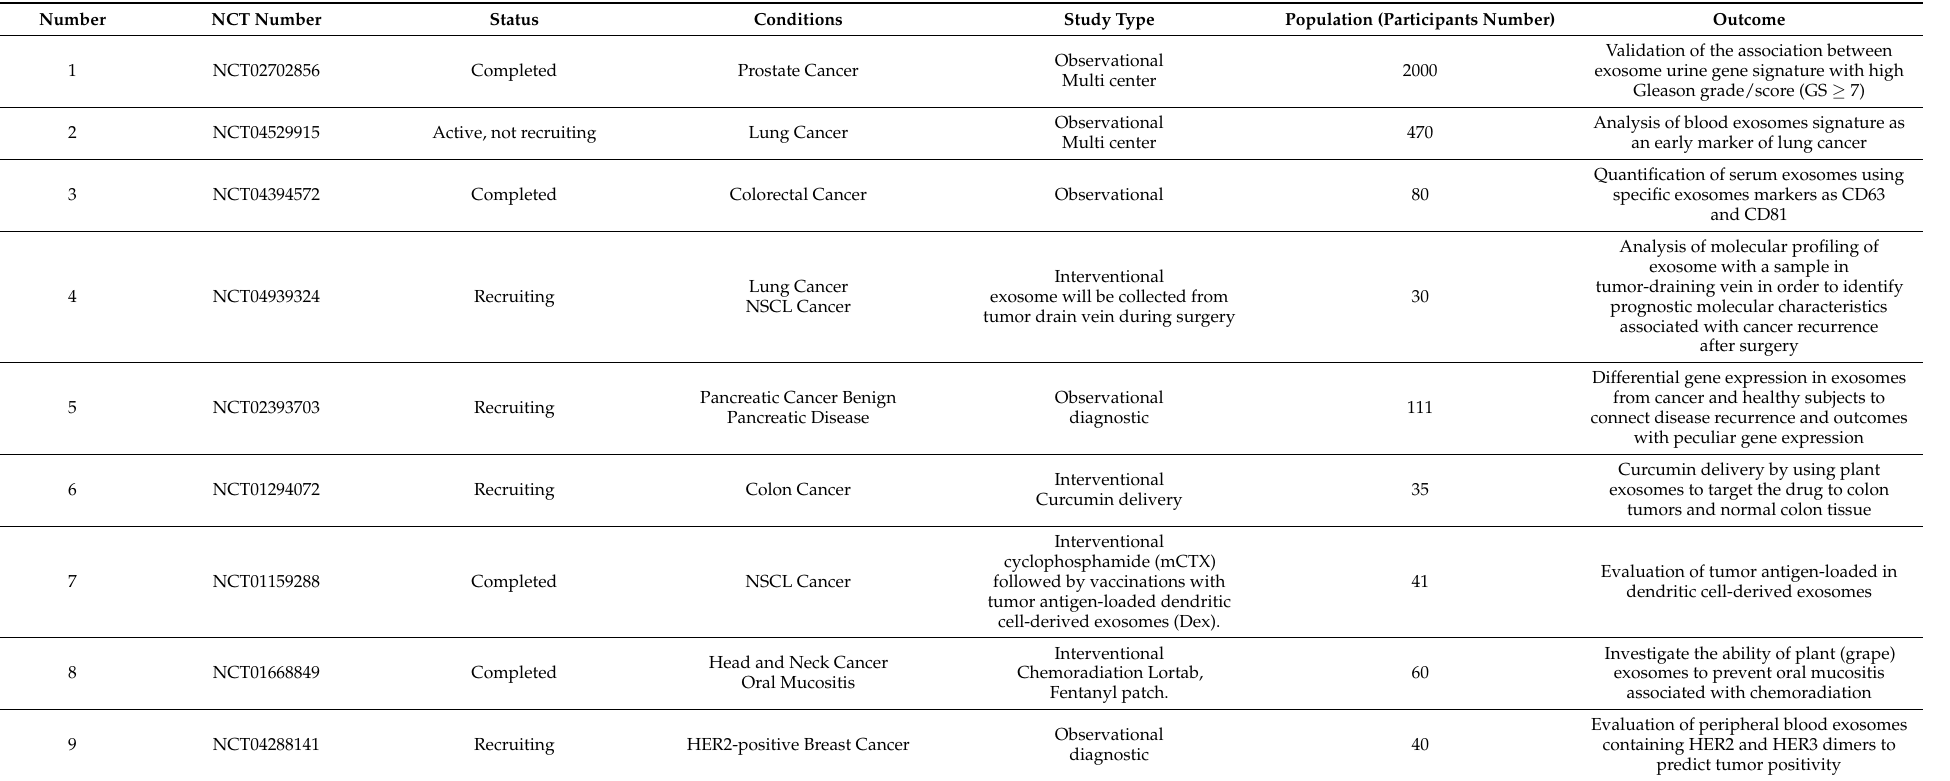
Table 2. Clinical studies of EV evaluation as diagnostic biomarkers for cancer